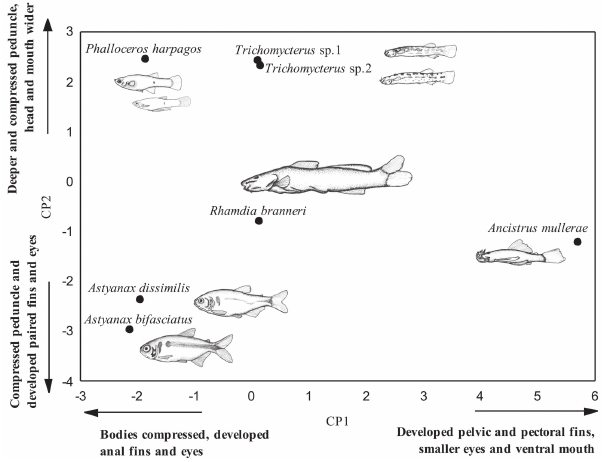
Fig. 2. Ordenation of the fish fauna in Jumelo stream, Iguaçu National Park, Paraná, Brazil, produced by the first - two axes of the principal components analysis (PCA 1 and PCA 2) applied to the correlation of 15 ecomorphological indices and the mouth orientations of the fish